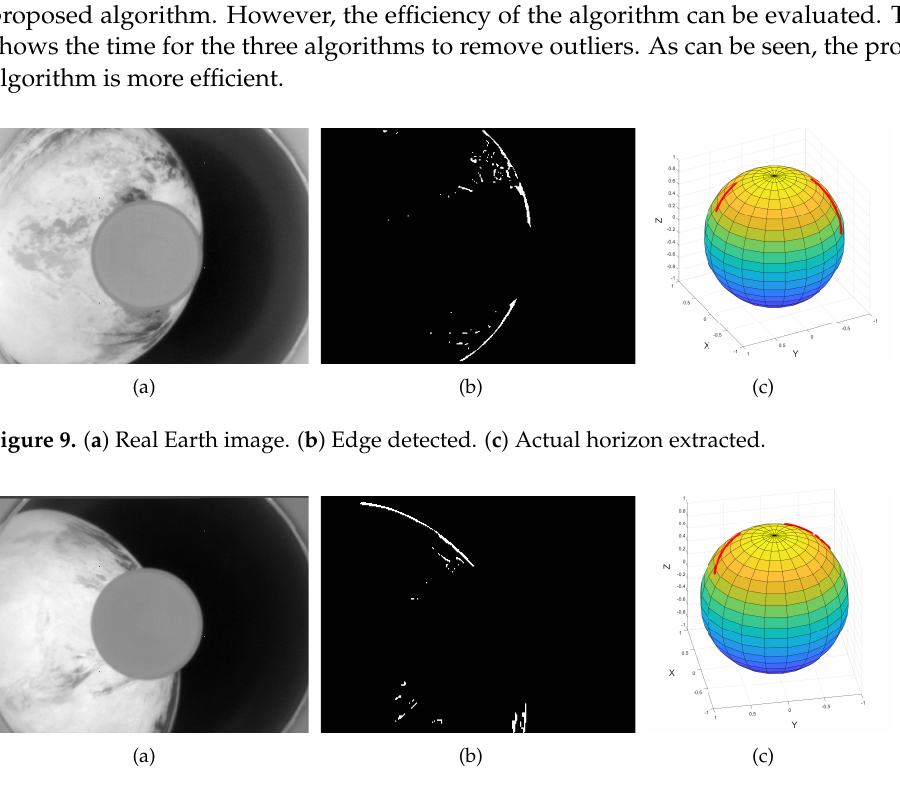
Figure 10. ( a ) Real Earth image. ( b ) Edge detected. ( c ) Actual horizon extracted. Table 2. The time for outlier